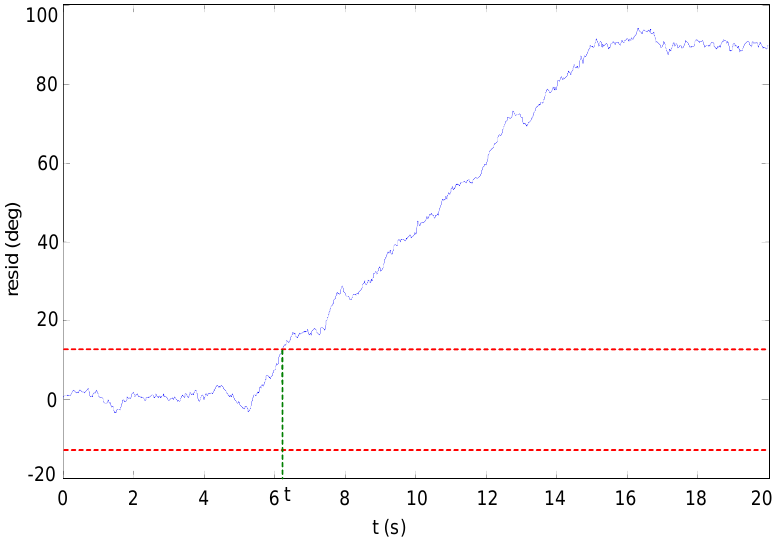
Figure 7. Actuator fault